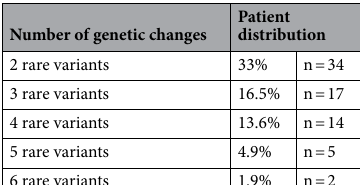
Table 2. Distribution of patients with 2 or more rare